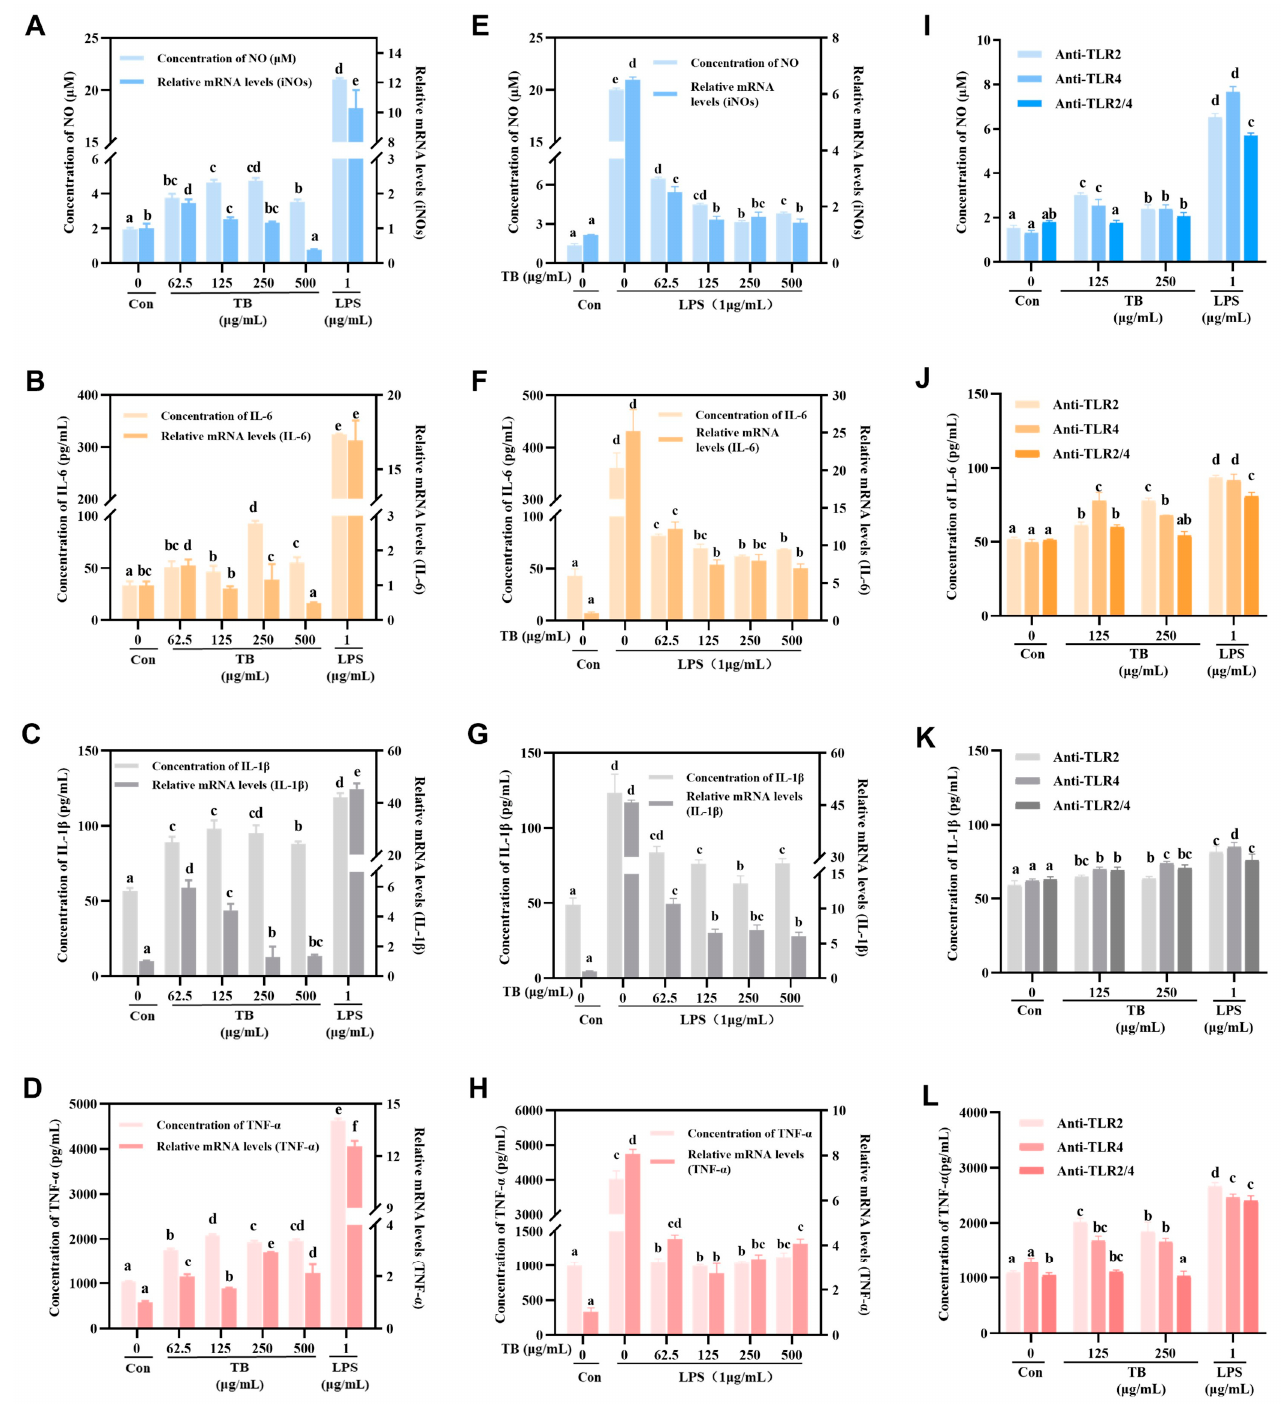
Figure 2. Effects of TB on production of NO and cytokines (IL-6, IL-1 β , and TNF- α ). ( A – D ) The content and mRNA expression of RAW264.7 cells from secreting NO and cytokines following TB treatment. ( E – H ) The content and mRNA expression of LPS-induced RAW264.7 cells from secreting NO and cytokines following TB treatment. ( I – L ) The content of RAW264.7 cells from secreting NO and cytokines following anti-TLR2, anti-TLR4, or anti-TLR2/4 treatment. The statistically significant differences are marked with different letters (a, b, c, d, e,